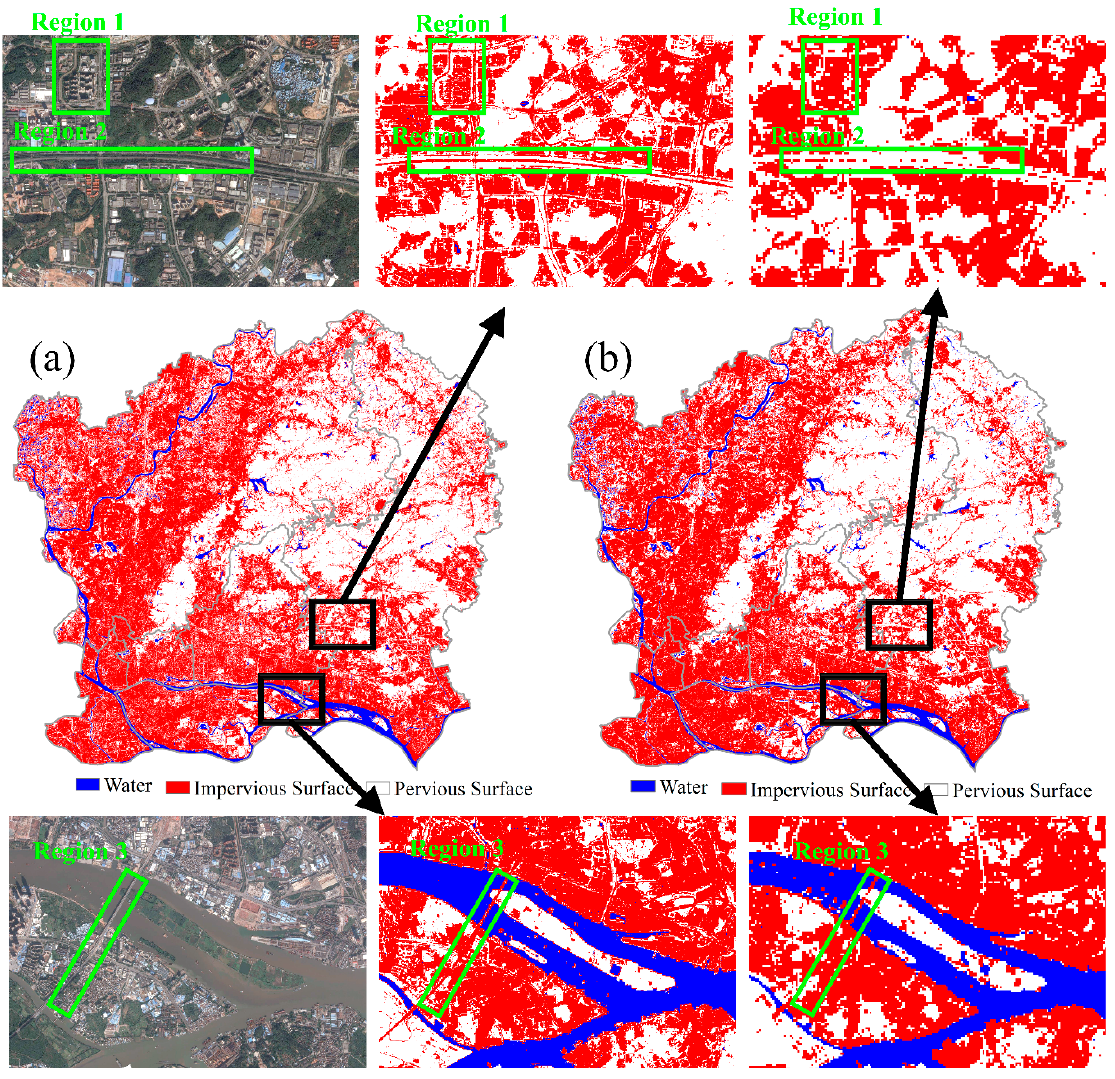
Figure 8. Comparison of impervious surface maps: ( a ) Sentinel-2A, ( b ) Landsat 8.